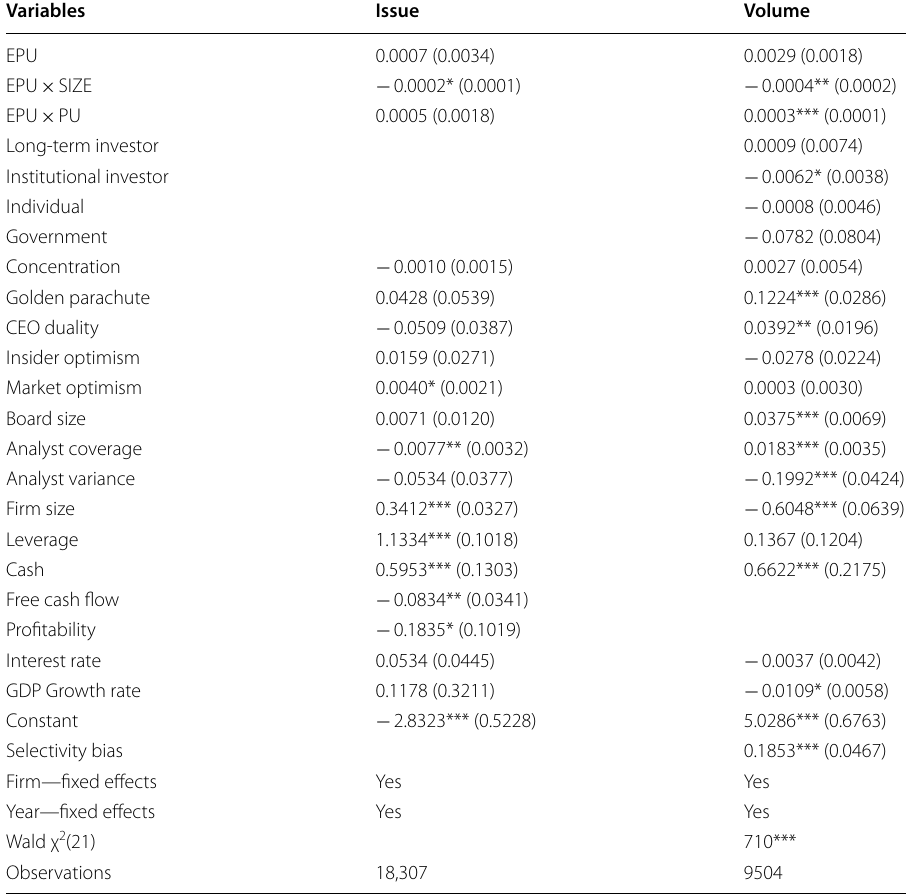
Table 8 Empirical estimation based on the Heckman two-stage model without the Choice equation with firm-fixed effects and year-fixed effects and robust standard